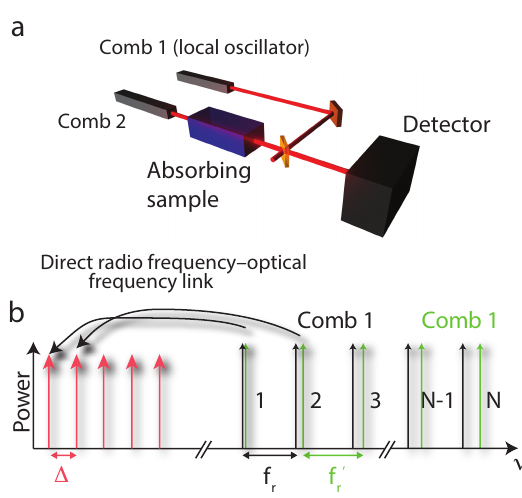
Figure 2: Principle of dual-comb spectroscopy. a Schematic diagram of a dual-comb spectroscopy setup. b Schematic diagram in the frequency